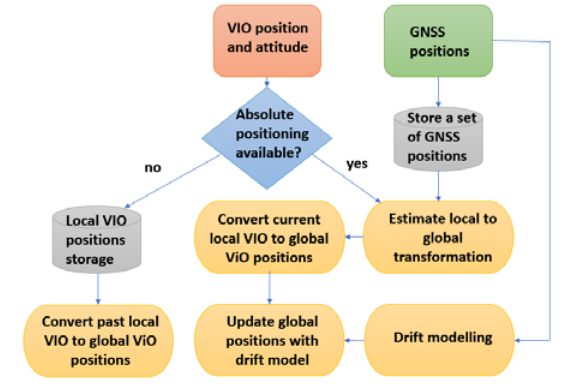
Figure 2. Flowchart for the sensor fusion